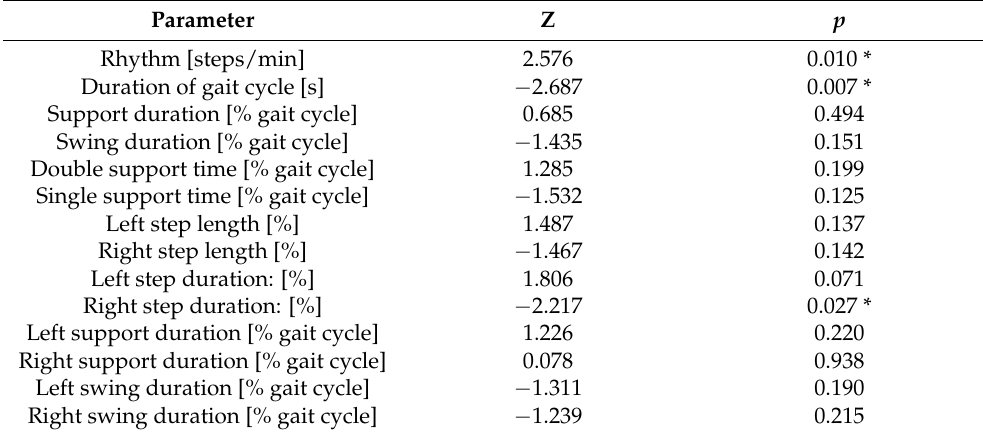
Table 3. Relationship of gait parameters with mandibular alignment (Mann–Whitney U test for p ≤